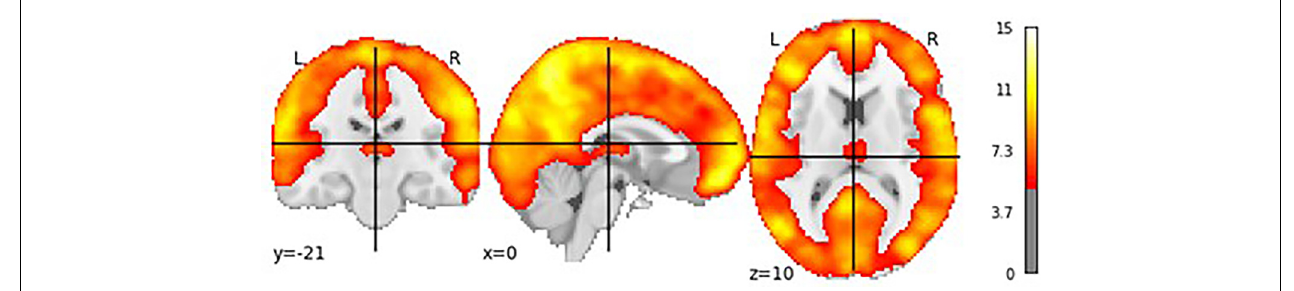
FIGURE 5 | T-test showing voxels whose brain activity was significantly captured by the oscillatory